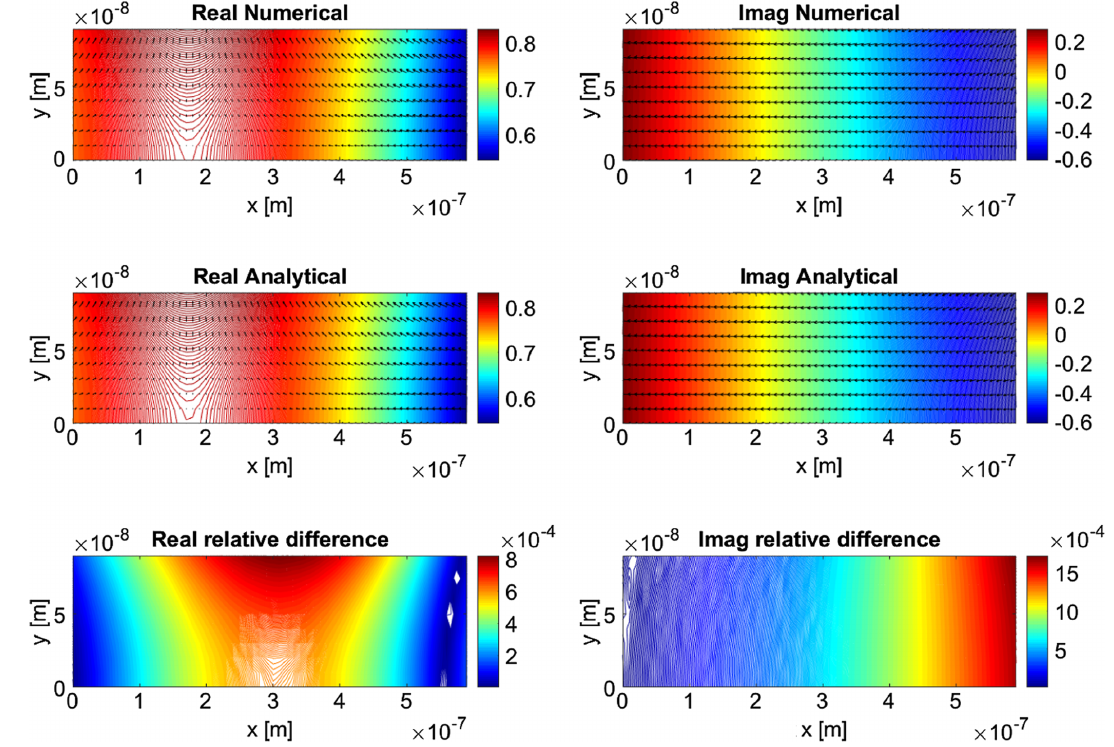
⃗ f ð x; y Þ for the tilted grating with α ¼ 30 deg. The fields have been obtained both 1